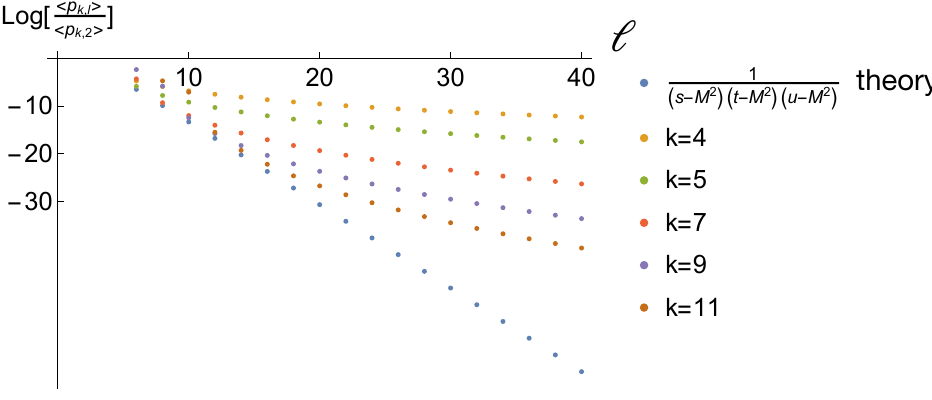
in the su -EFThedron h p k, 2 i